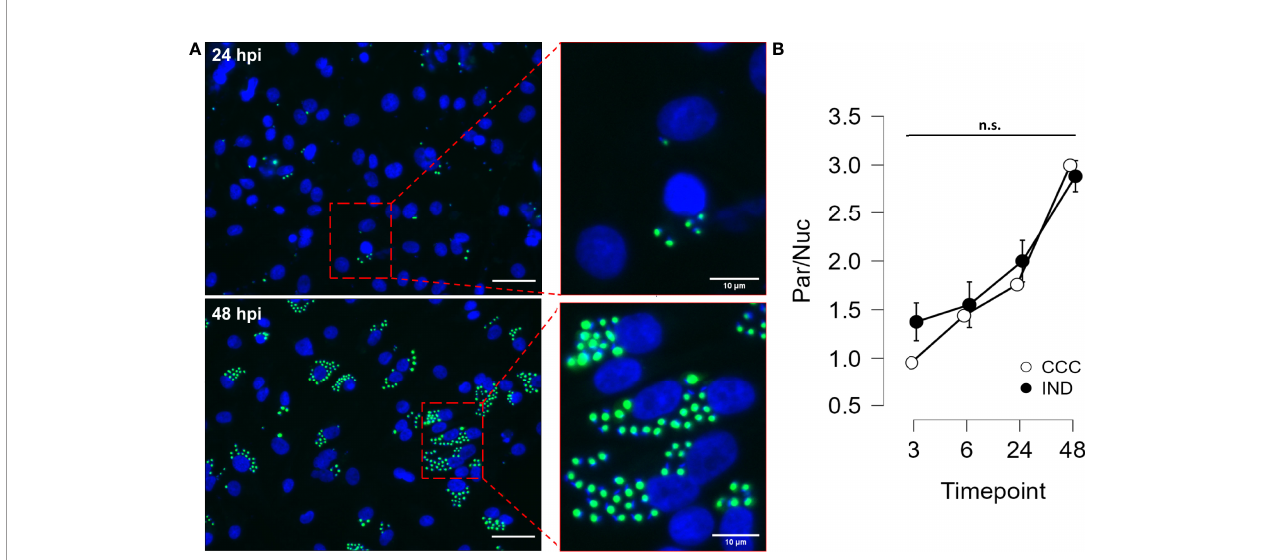
FIGURE 2 | Results from hiPSC-CM infection assay with GFP-expressing Y strain. (A) hiPSC-CM were infected with T. cruzi Y strain modi fi ed to express GFP in the amastigote form. Cell nuclei were stained with DAPI (blue) (Left panel bars = 40µm). (B) Time course (3, 6, 24 and 48 hpi) analysis of infection in hiPSC-CM from IND and CCC patients. Nuclei and amastigotes were counted in a custom script and the Parasite/Nucleus ratio was compared along time points. (n = 3 CCC and 2 IND). n.s., not signi fi cant.